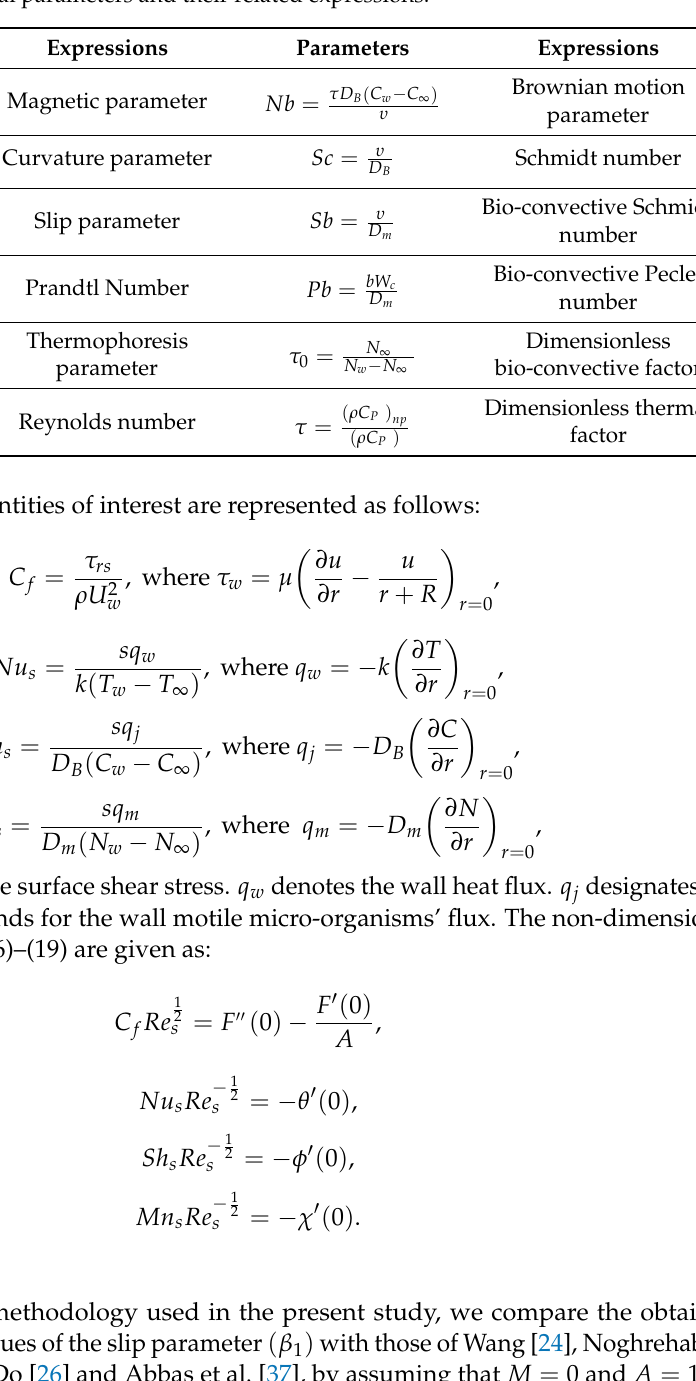
Table 1. Non-dimensional parameters and their related